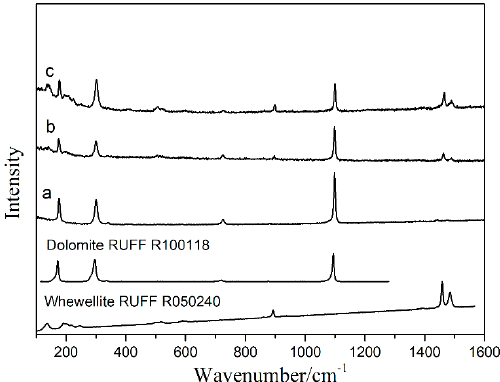
Figure 11. Raman spectra of the specimens: (a) UT, (b) AO, and (c) 0.02 mol/L CA were treated with 750 mL acid solution (HNO 3 :H 2 SO 4 = 1:1) with an initial pH of